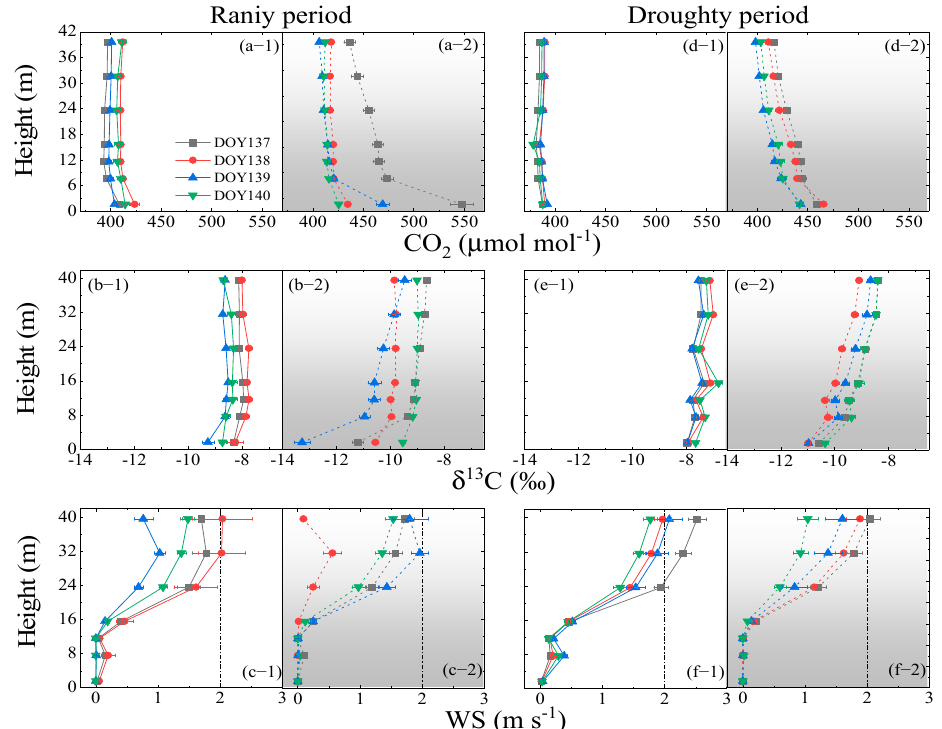
Figure 6. Daily mean vertical variations of ecosystem CO 2 ( a , d ), its δ 13 C ( b , e ) and wind speed (WS) ( c , f ) for each day during the typical rainy (DOY 137–140) and drought (DOY 215–218) periods. White and grey areas represent the diurnal (10:00–16:00) and nocturnal (22:00–4:00) results, respectively.